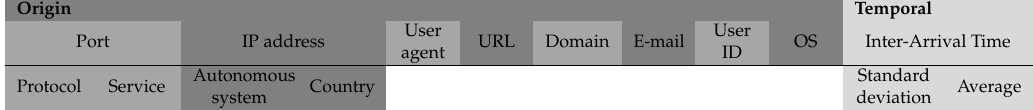
Table 2. Part of sample feature set for attackers’ classification suggested in [40].